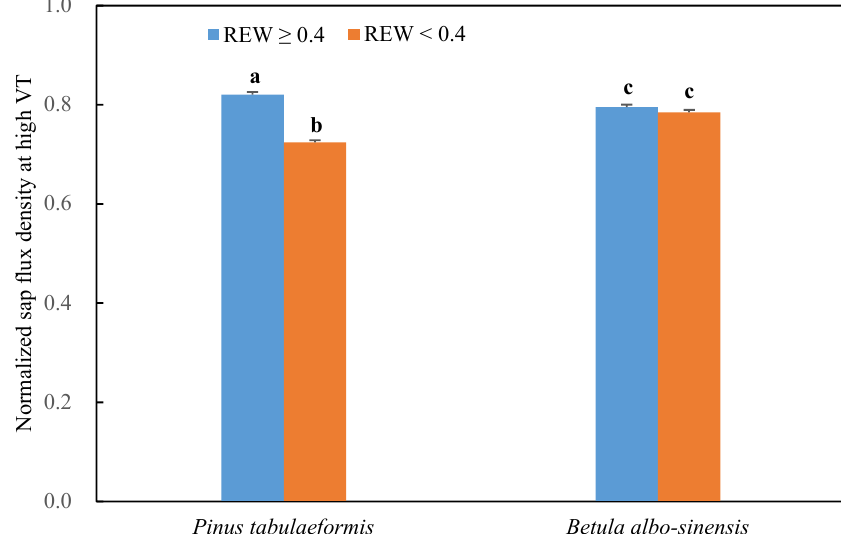
Figure 7. Normalized sap flux density of each species for datasets with a VT ≥ 40 kPa (W m − 2 ) 1/2 on different soil-water conditions over the three months. Error bars represent standard errors ( n was 144 when the REW ≥ 0.4 and it was 431 when the REW <0.4). Means with different letters are significantly different at p < 0.01.